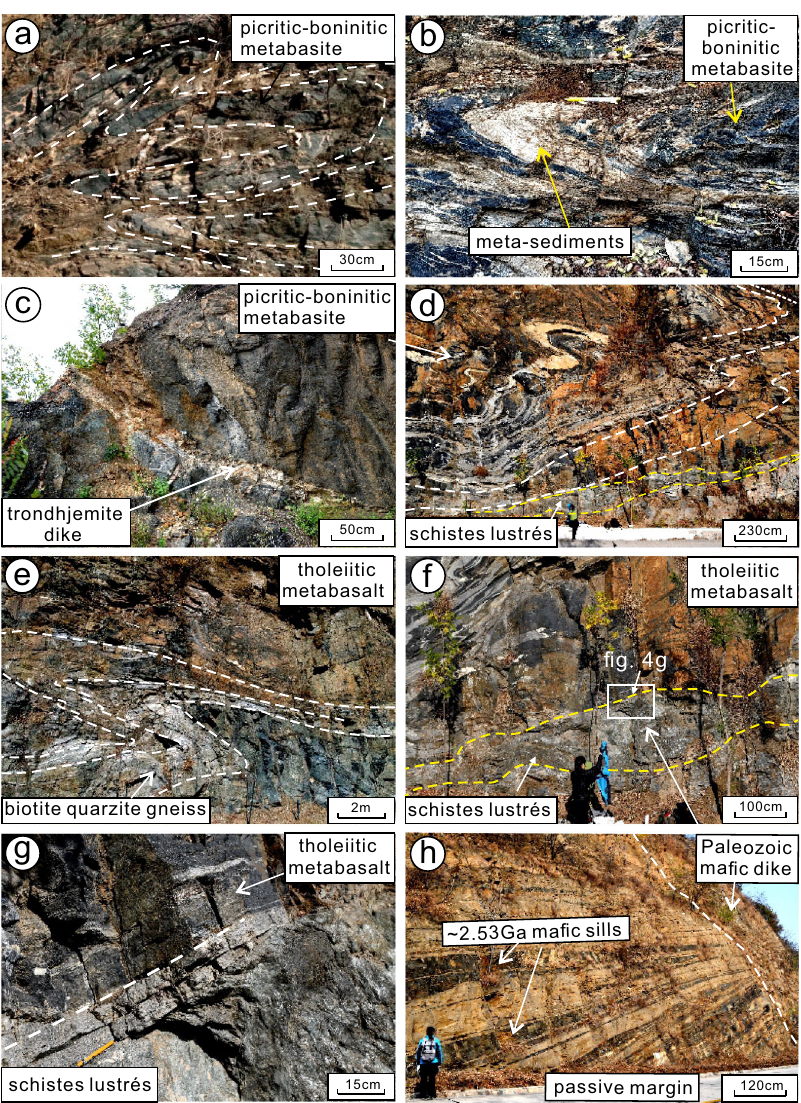
Fig. 4 Field photographs illustrating fi eld relationships and lithological characteristics in the Buddha and Black Rock Temple nappes, Zanhuang Complex. a Folded amphibolites of picritic-boninitic composition from the picrite-boninite unit of the Back Rock Temple nappe; b tight to isoclinally folded picritic-boninitic metabasite (dark layer) with magnetite-quartzite (light layer, interpreted as meta-hydrothermal chert); c detail of picritic-boninitic metabasites crosscut by trondhjemite dike; d recumbent nappe with parasitic folds of tholeiitic basalt composition resting upon the thrust fault de fi ned by the schistes lustrés layer. Note that this is an oblique view with highly curved hinge surfaces that vary from the core to the outside of the fold structure: e tholeiitic metabasalts and biotite-quartzite gneiss disposed in a large-scale recumbent fold in the Buddha nappe (one layer is outlined with white dashed line); f the variably-thin schistes lustrés layer, marking the thrust (suture) between the allochthonous IAT tholeiites of the Buddha nappe (above) and the autochthonous siliciclastic metasediments of the passive-margin sequence below; g detail of the contact (along yellow pencil) of the schistes lustrés thrust zone with overlying allochthonous Buddha nappe, represented by folded tholeiitic basalts. Pencil (yellow) is on the top of the schistes lustrés thrust zone. h Footwall metasediments of the passive-margin sequence in the Buddha nappe intruded by 2.53Ga ma fi c sills and Paleozoic dolerite